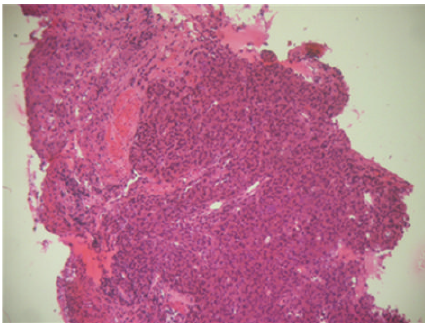
Figure 4: Esophageal tumor containing a mixture of epitheliod and spindle-shaped cells (HE × 40).